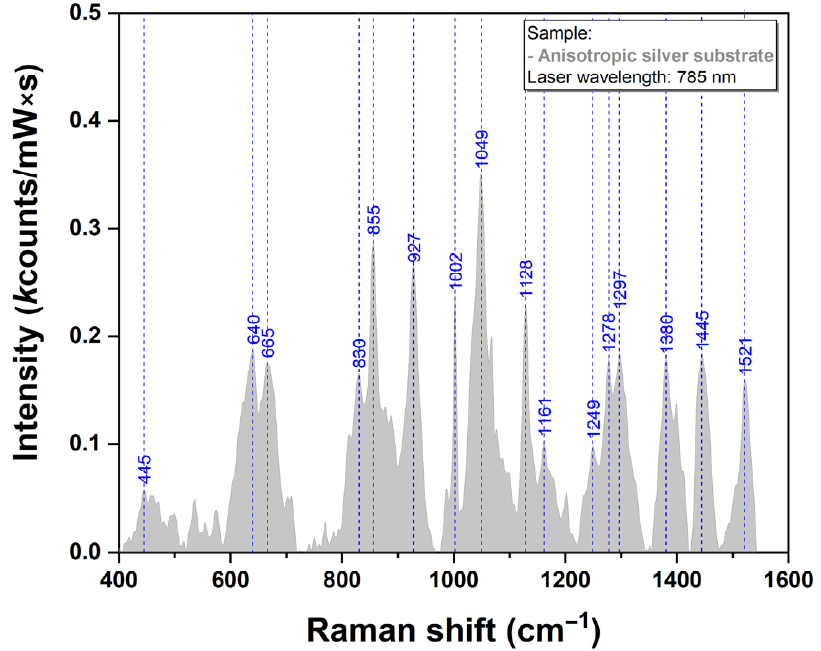
Figure 6. Raman spectra of AgNS recorded using a 785 nm laser